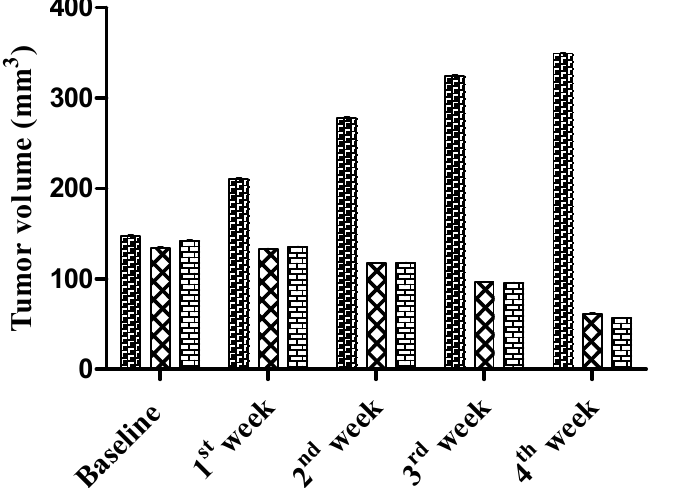
Figure 2. Average tumor volume per week in different groups. Table 2. Nutritional parameters of different groups.